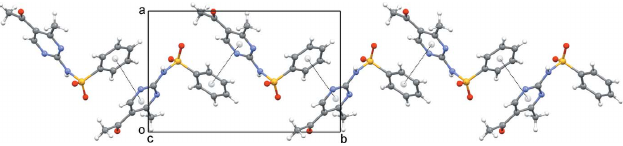
Figure 3 A segment of the crystal structure showing a chain of molecules linked by (cid:2) – (cid:2) interactions. The dotted lines connect the centroids of the molecules involved.